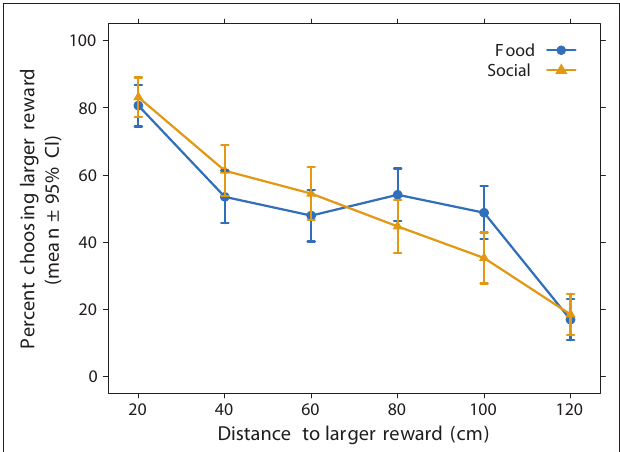
Figure 3 | effect of reward type on spatial discounting using aggregate data. We presented subjects with a choice between two versus six food items (food-reward condition, blue circles) or two versus six same-sex conspecifics (social-reward condition, yellow triangles). The smaller reward remained at 20 cm. Choice for the larger reward decreased with the distance to the larger reward. The linear regression equations (not illustrated) for the food and social conditions were y = - 0.5 x + 82.9 and y = - 0.6 x + 90.6, respectively. We used all subjects in this analysis ( N = 14), thus including subjects that experienced both conditions ( N = 6) and subjects that experienced only one condition ( N = 8).